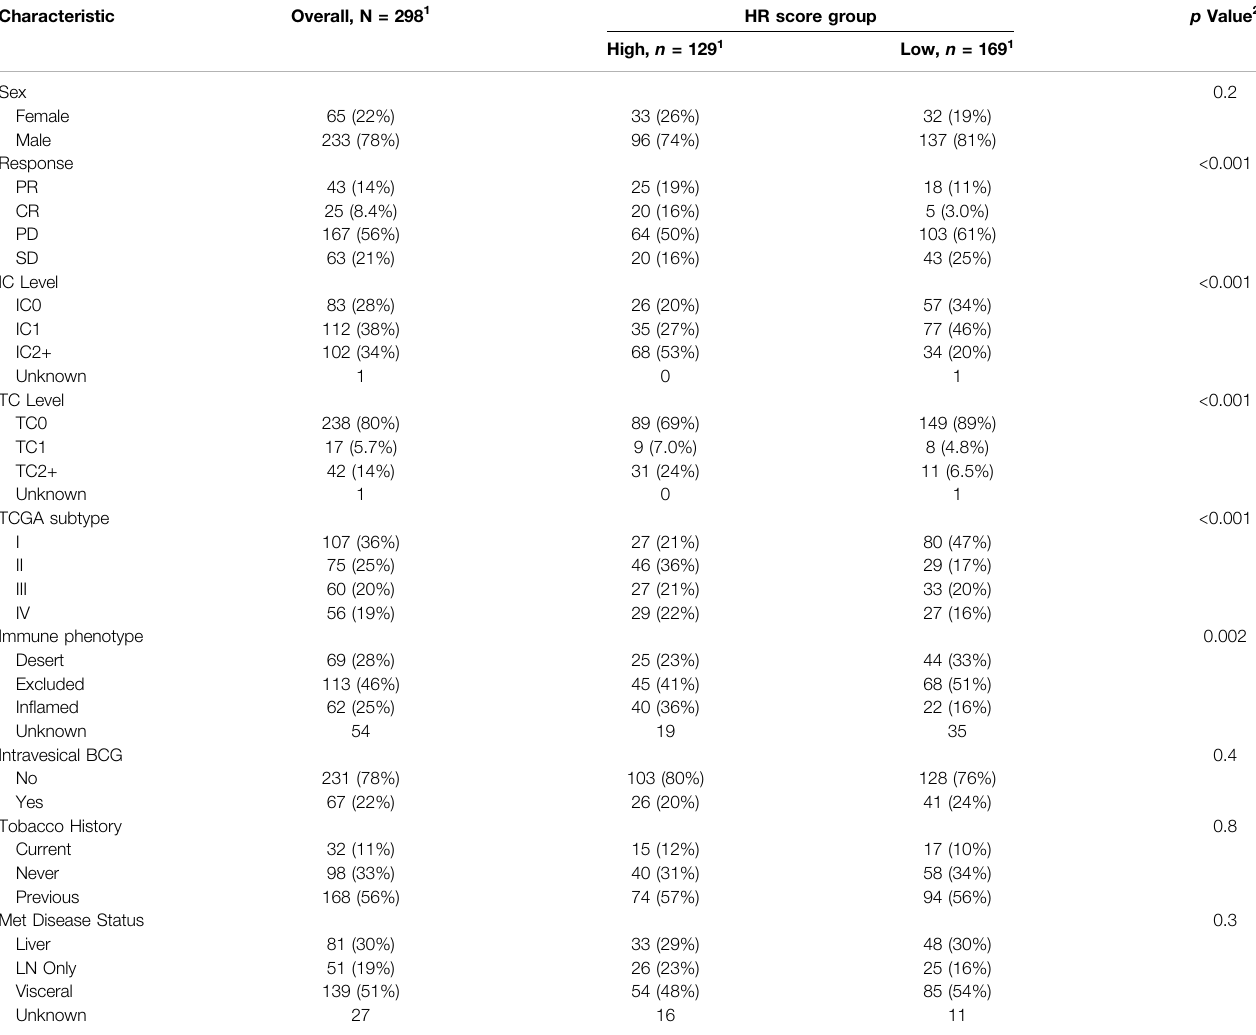
TABLE 2 | Patient